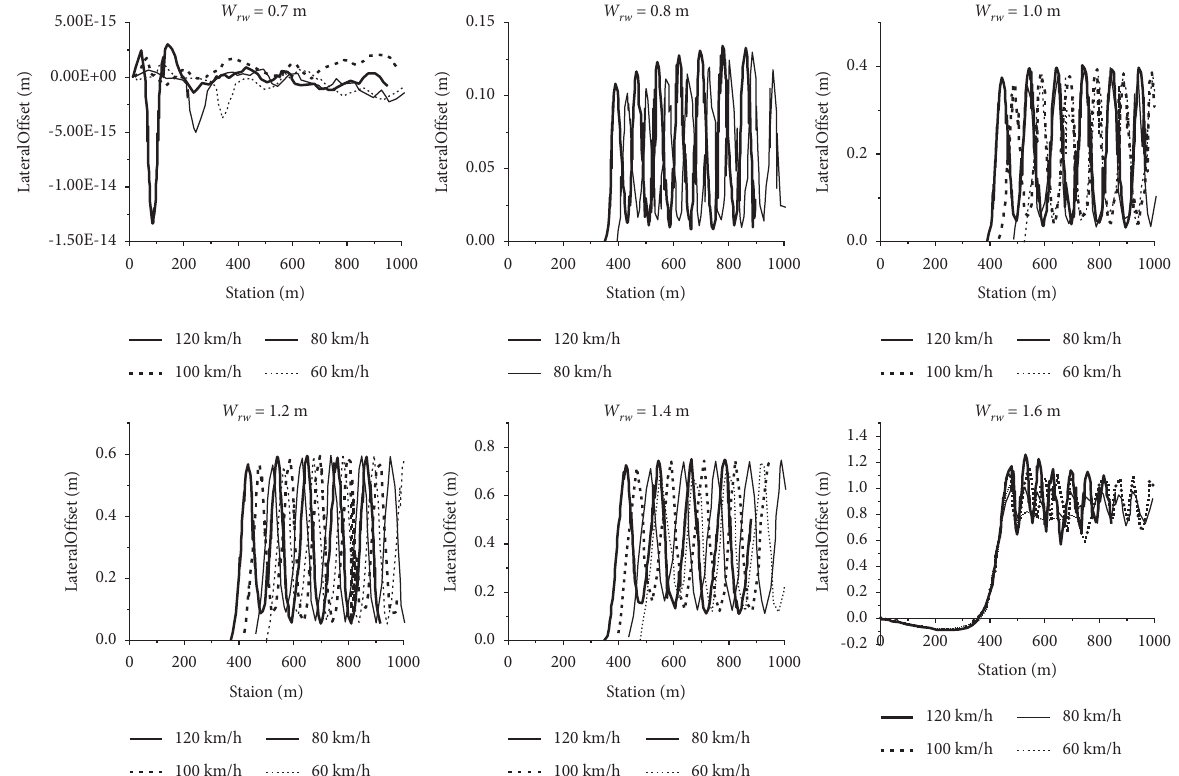
Figure 11: Lateral offset from design path at different rutting widths and speeds. (a) W (d) W rw � 1.2m, (e) W rw � 1.4m, and (f) W rw � 1.6 m.